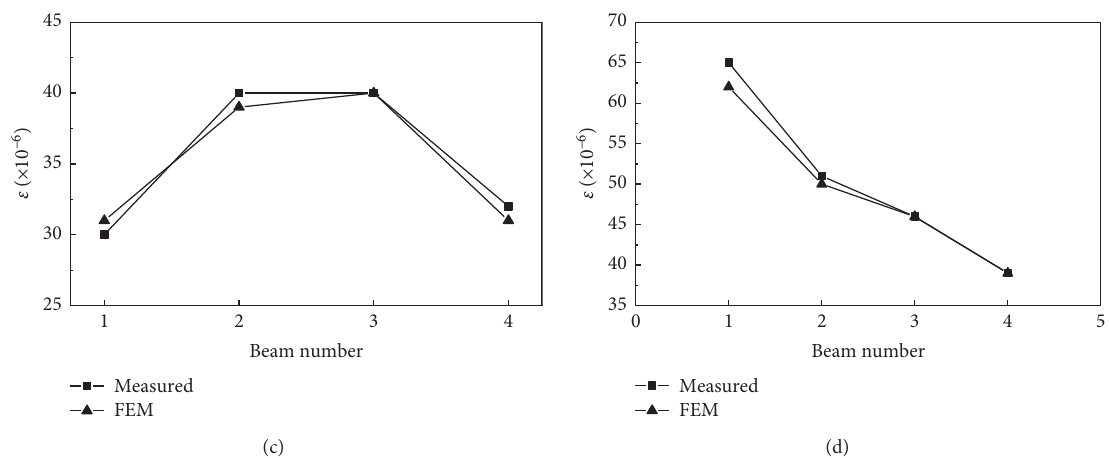
Figure 16: Comparison between numerical and experimental strain values. (a) Strain at section A-A during working condition I-1. (b) Strain at section B-B during working condition I-2. (c) Strain at section A-A during working condition I-2. (d) Strain at section B-B during working condition II-2.